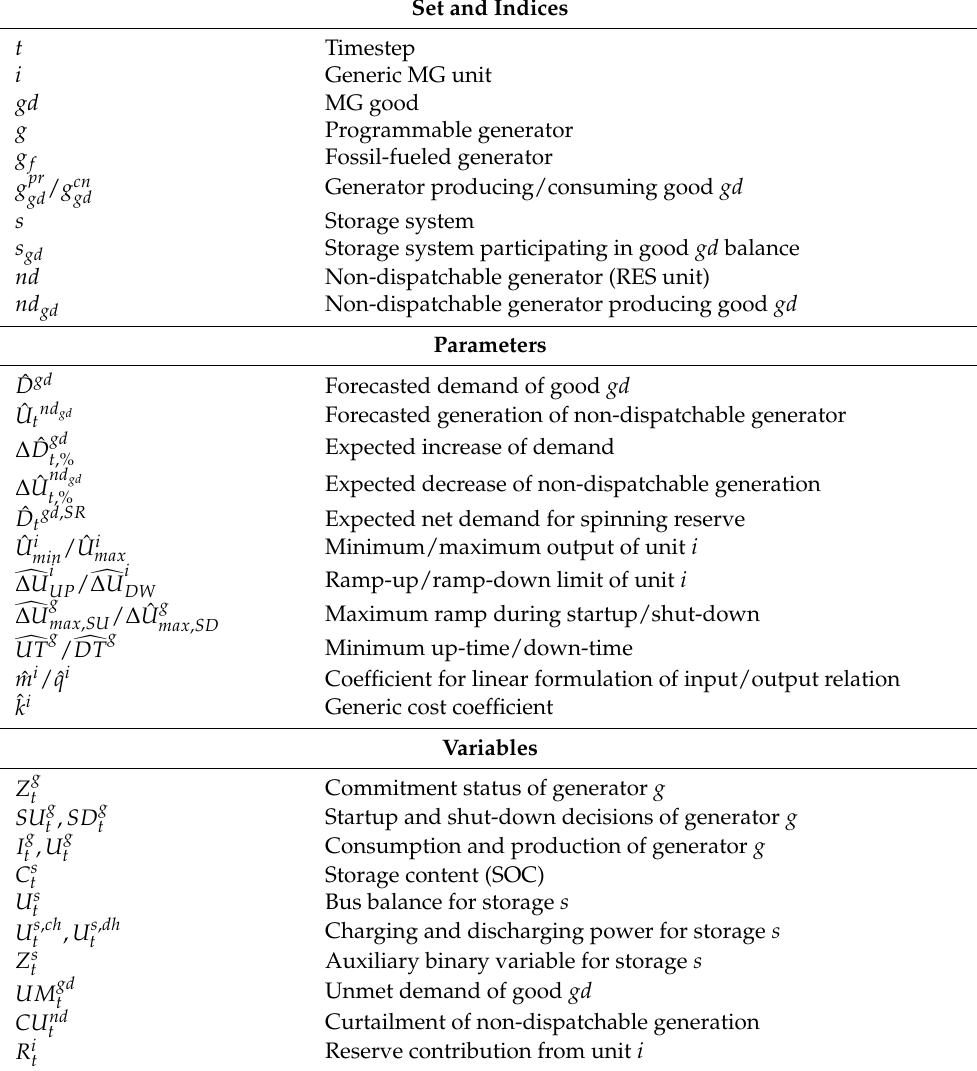
Table A1. Nomenclature for optimal UC